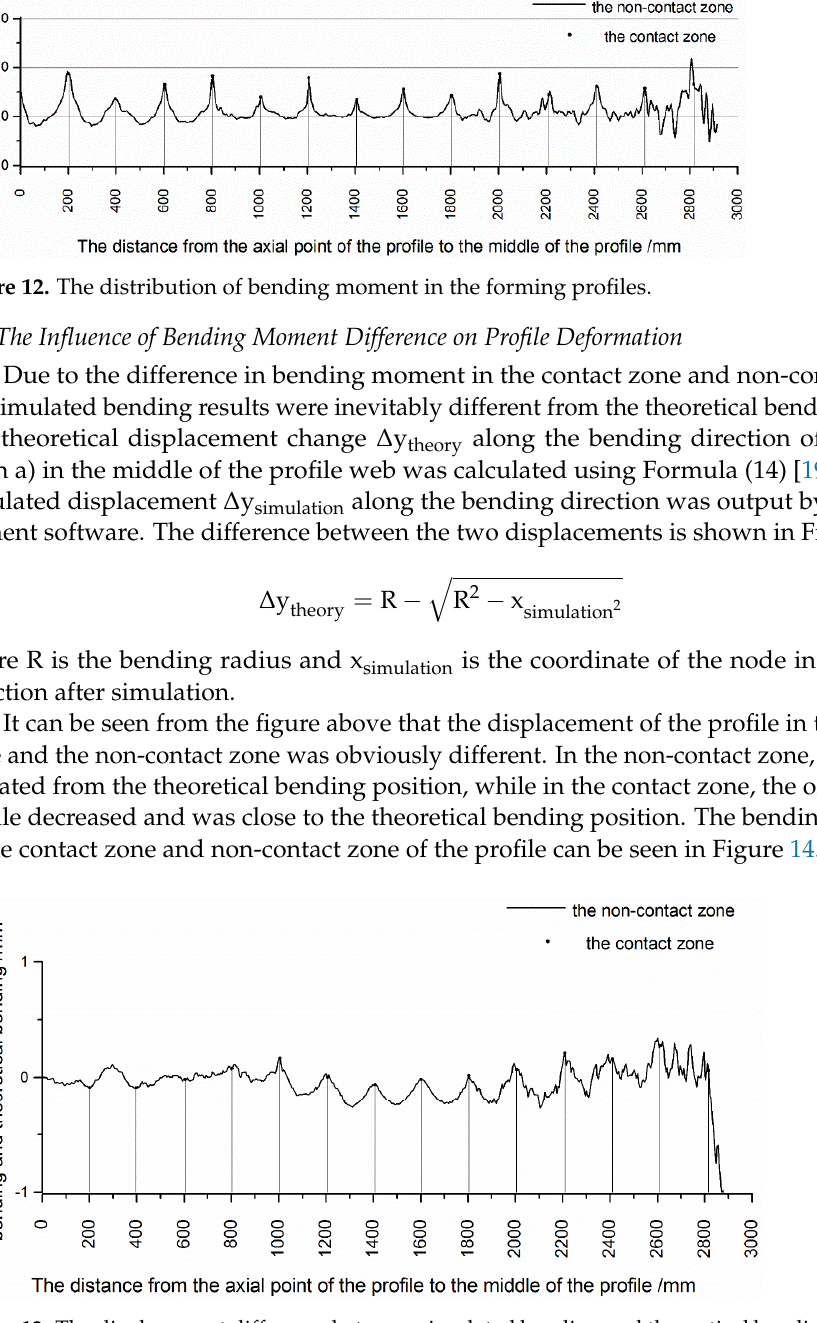
Figure 13. The displacement difference between simulated bending and theoretical bending of profile.